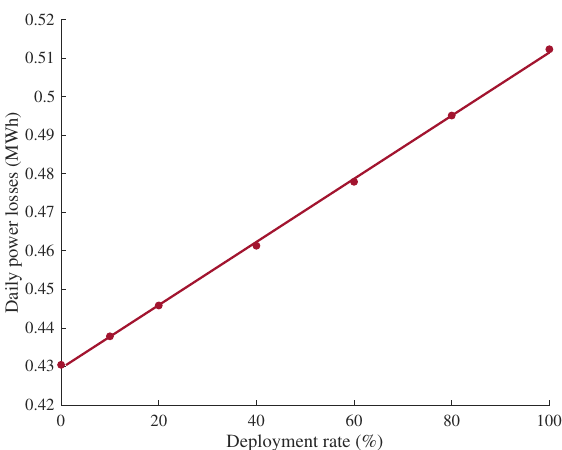
Figure 13. Power losses with different EVs deployment rates.